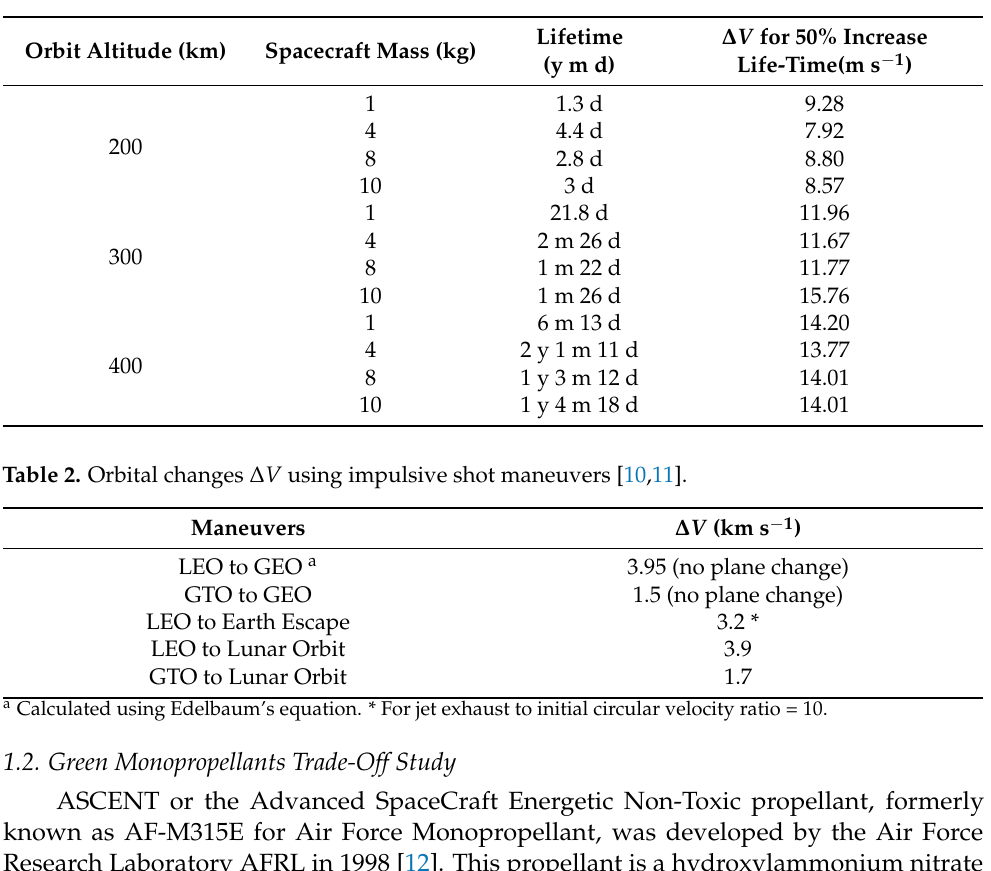
Table 1. Drag compensation for nanosatellites in LEO [10].